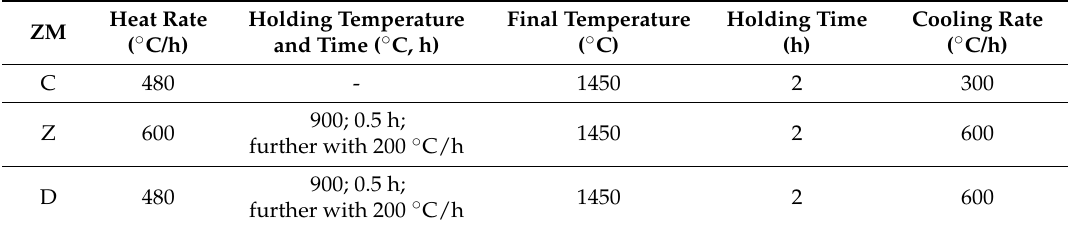
Table 3. Sintering parameters of all tested zirconia materials used in this study.